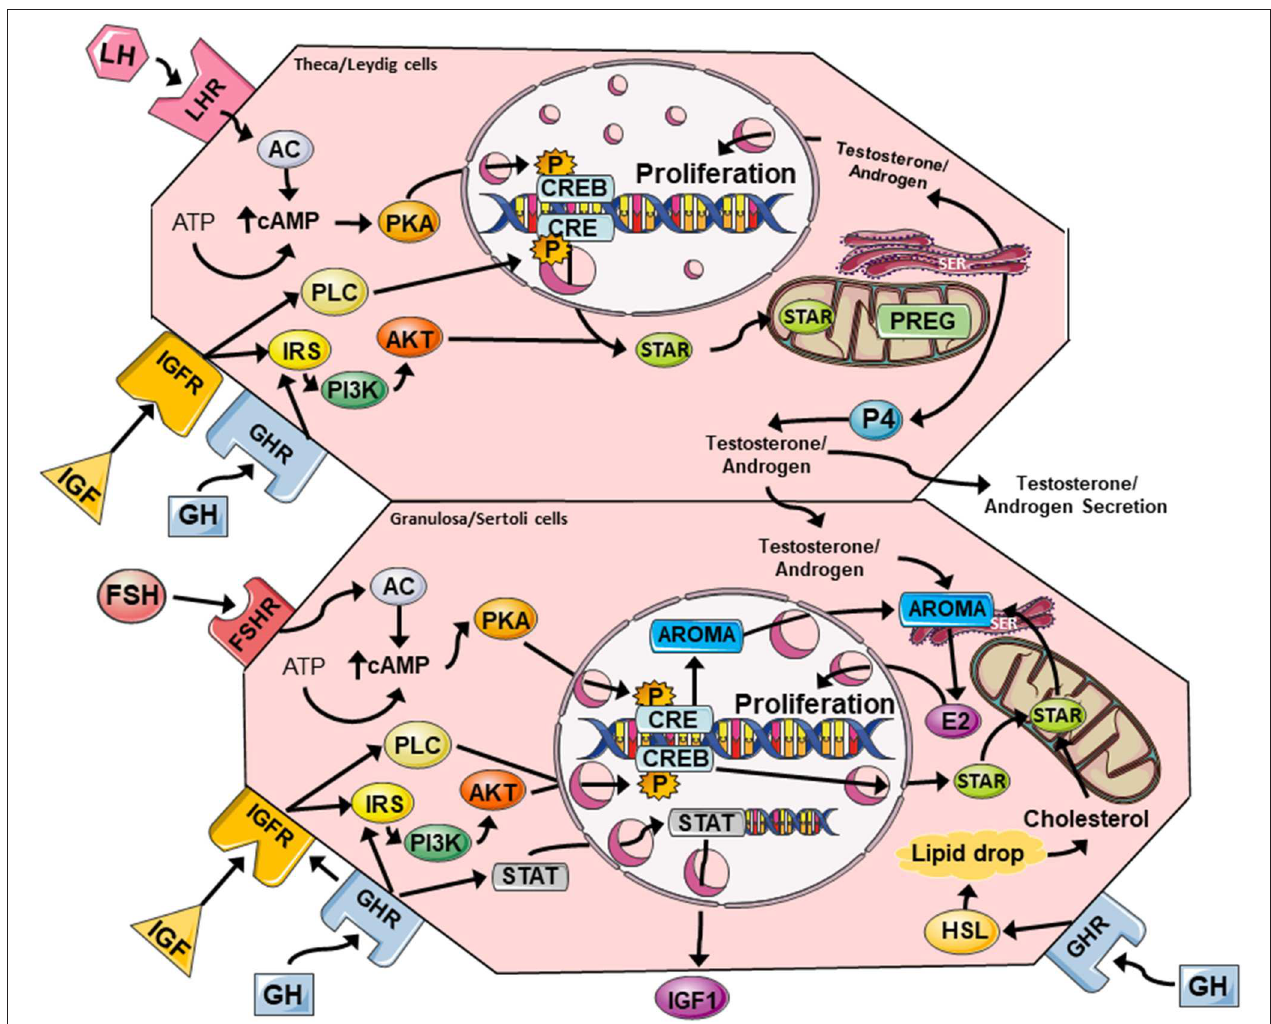
FIGURE 2 | A summary of the major GH and IGF signaling networks in female (theca/granulosa cell) and male (Leydig/Sertoli cell) reproductive physiology. Both GH and IGF can activate PLC/PKC and PI3K/Akt pathways that cross-talk with FSHR and LHR signaling via cAMP/PKA to promote steroidogenesis and cell proliferation. Steroidogenic events are mediated by CREB-dependent expression of aromatase (granulosa cells), and StAR expression in all cell types. StAR allows cholesterol to enter the mitochondria where it can be converted to PREG, and then subsequently to testosterone/androgens, estrogens, and progesterone. Estrogens and testosterone enhance cell proliferation via autocrine mechanisms, while GH can induce local IGF expression in granulosa and Sertoli cells via JAK/STAT signaling. LHR, luteinising hormone receptor; FSHR, follicle stimulating hormone receptor; AC, adenylate cyclase; cAMP cyclic AMP; PKA, protein kinase A; CRE, cAMP response element; CREB, cAMP response element binding protein; PLC, phospholipase C, IRS, insulin receptor substrate; PI3K/Akt, phosphoinositide 3-kinase/protein kinase B; StAR, steroidogenic acute regulatory protein; PREG, pregnenolone; SER, smooth endoplasmic reticulum; P4, progesterone; E2, estradiol; STAT, signal transducer and activator of transcription; AROMA, aromatase, HSL, hormone-sensitive